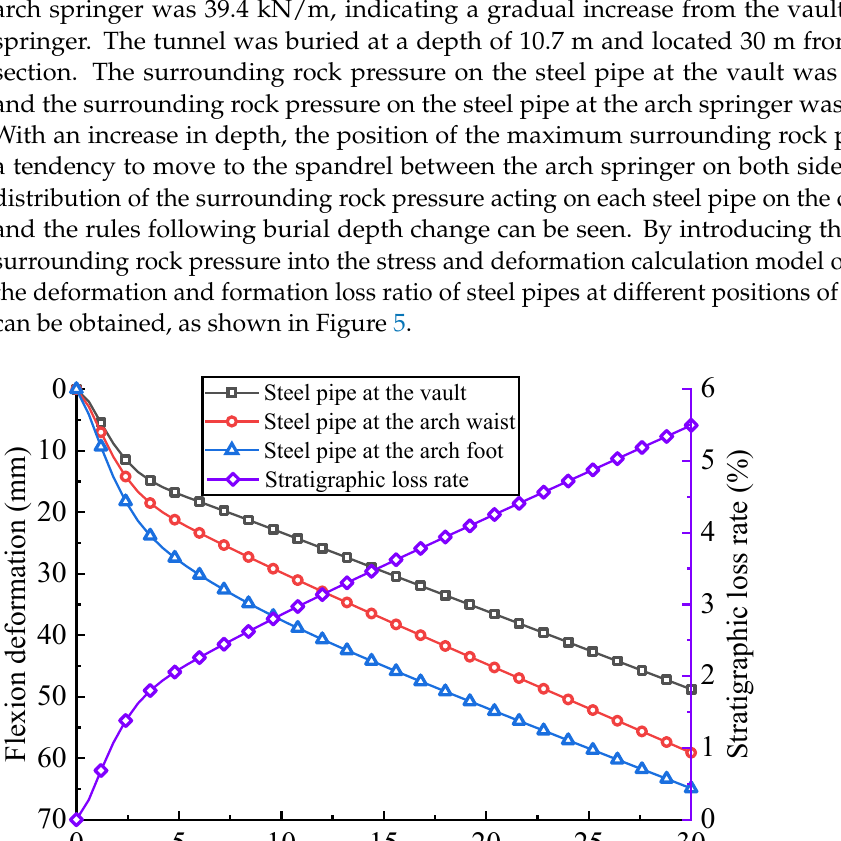
Figure 5. Distribution curve of steel pipe deflection deformation and ground loss rate.